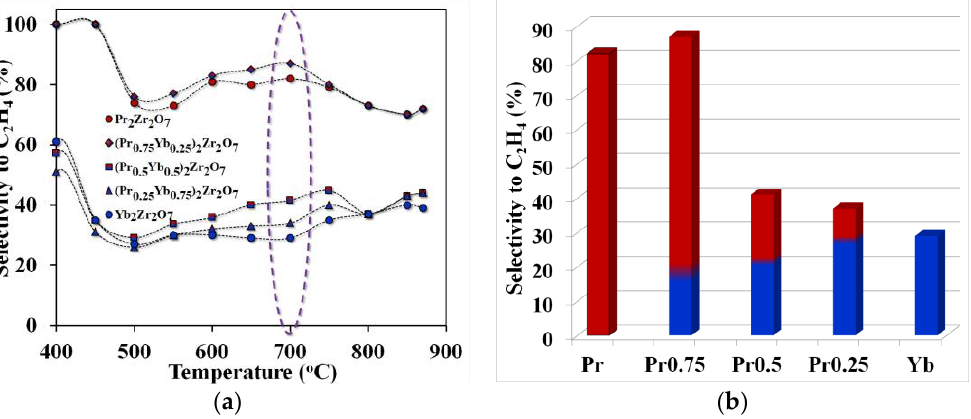
Figure 5. Temperature dependence of selectivity for ethylene (purple highlights the temperature of optimal technological conditions) — ( a ), selectivity for ethylene at the optimum cracking temperature — ( b ).